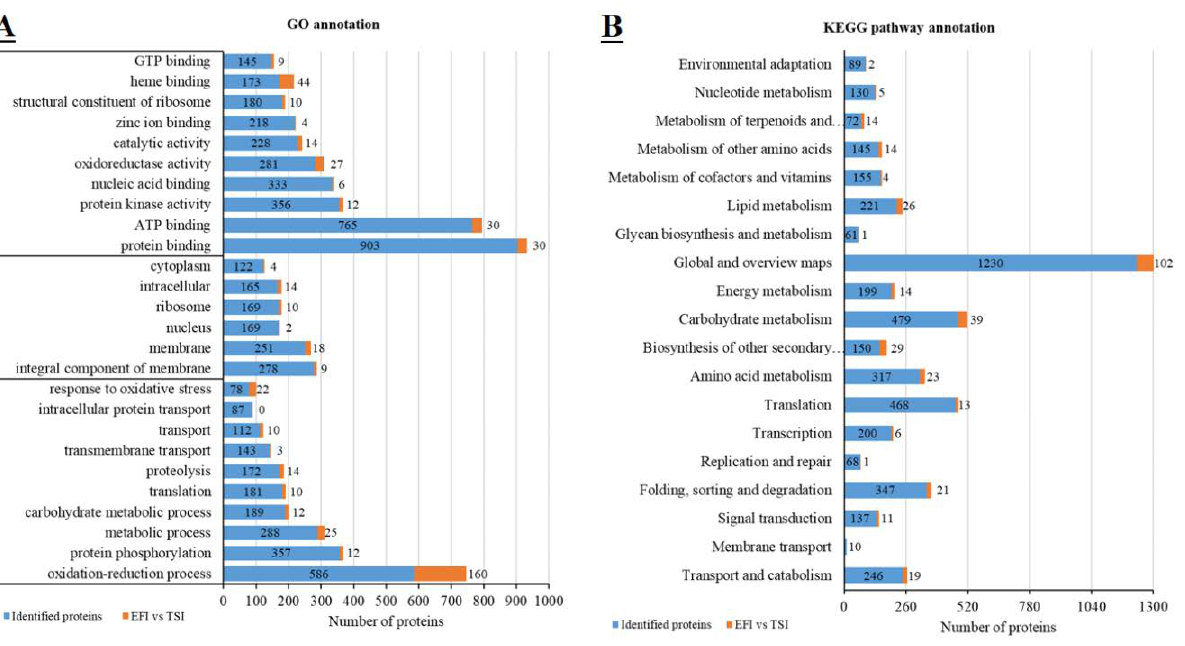
Figure 4. The GO ( A ) and KEGG ( B ) annotation of all identified proteins and DAPs (EFI vs. TSI). All proteins were classified by GO terms based on three categories: molecular function (MF), cellular component (CC), and biological process